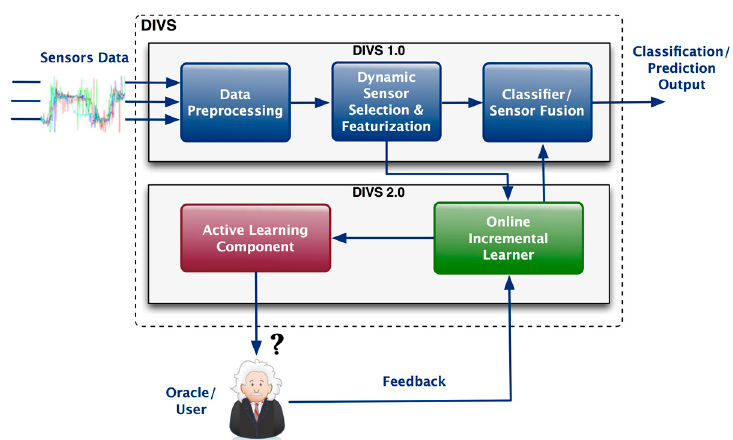
Figure 1. The DIVS data processing pipeline. DIVS 1.0 belongs to previous work and DIVS 2.0 is the extension included in this paper.